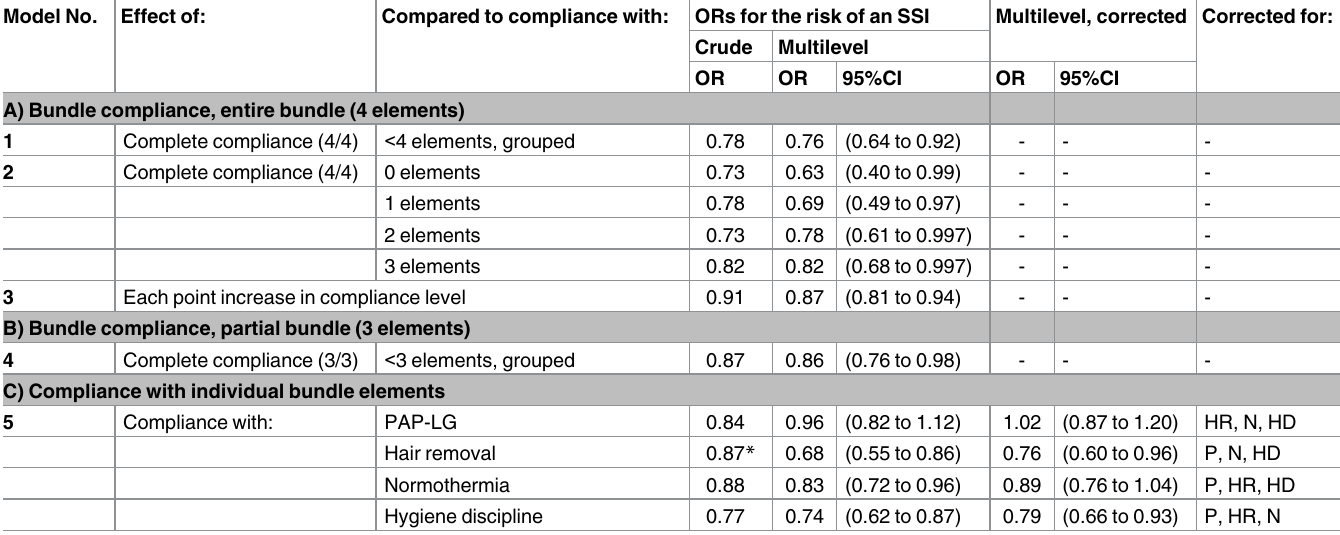
Table 5. Bundle compliance and compliance with individual bundle elements: Odds ratios (ORs) for the risk of an SSI. Model No. Effect